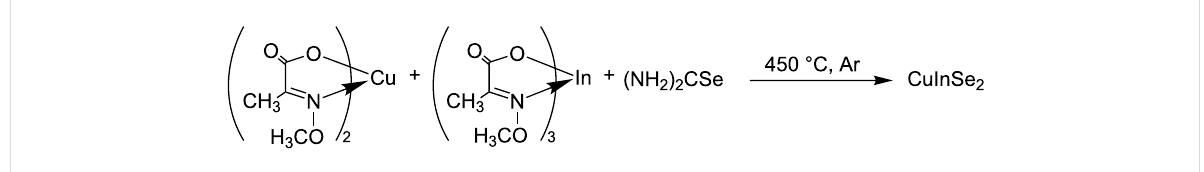
ethanol by ultrasonication and then deposited on copper TEM grids. X-ray analysis (XRD) of the species was carried out on a Stoe&Cie StadiP diffractometer in Debye–Scherrer geometry while using Cu K α 1 radiation ( λ = 1.541 Å) with a Ge(111) monochromator. Raman spectra were recorded from 50 to 2000 cm − 1 with a micro-Raman HR800 spectrometer (Horiba Jobin Yvon, Bensheim, Germany) while using laser wave- length of 514 nm. For the recording of absorption spectra the remission method was used. With a UV–vis–NIR spectrometer Lambda 900 from Perkin Elmer the remission was recorded and automatically converted to an absorption spectrum via the Kubelka–Munk-relation ((1 − R ) 2 /(2 R ), R is the normalized